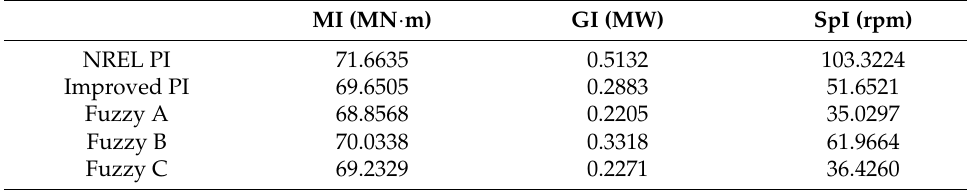
Figure 15. Comparison of the evaluated controllers for a wind profile of 15 m/s.